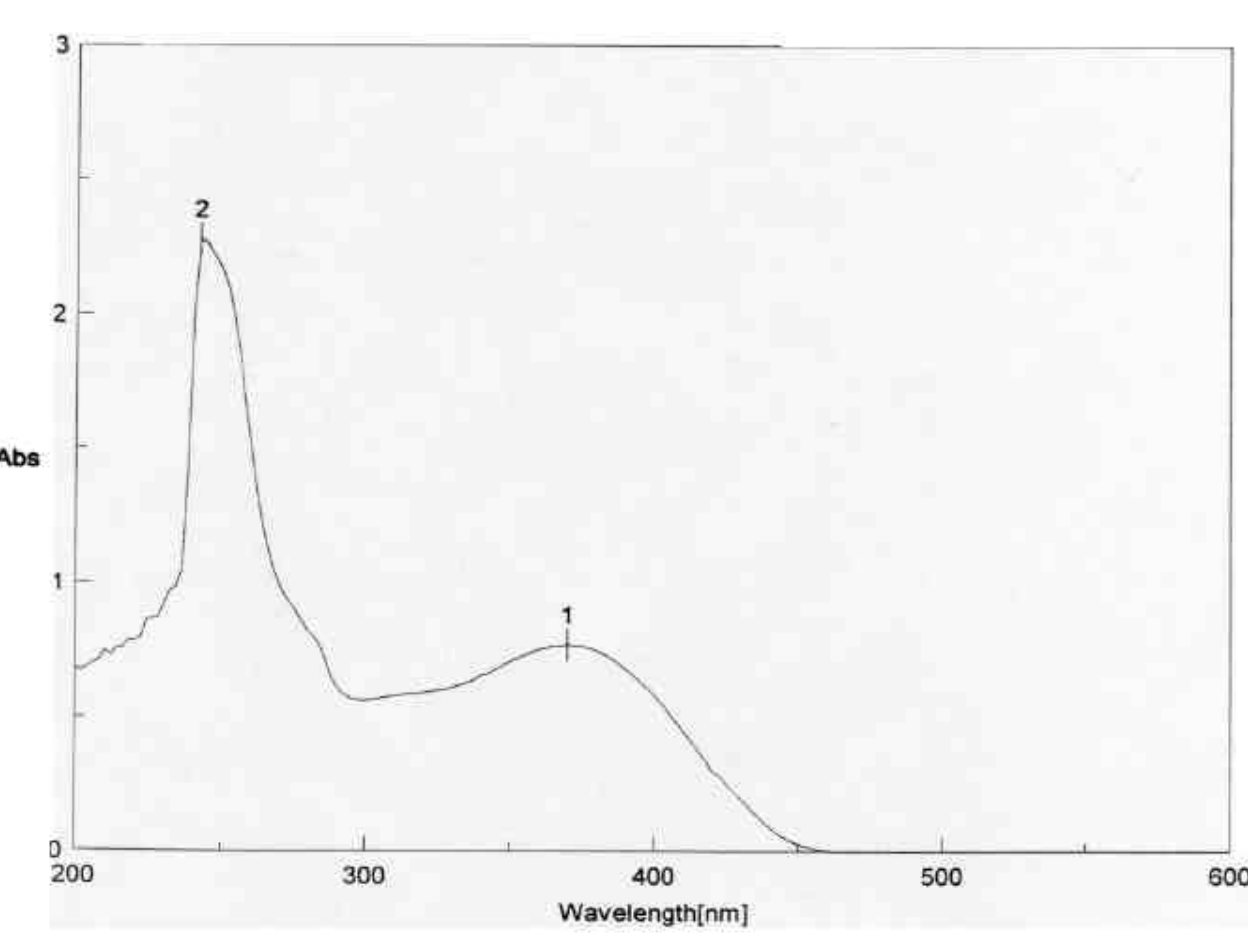
: 1: 370; 2: 242 max